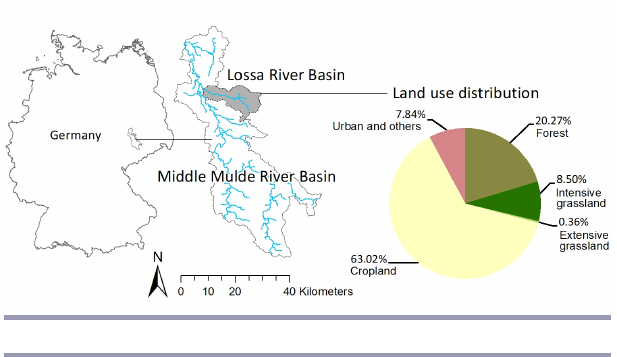
Fig. 3. Map showing the location of the case study area and pie chart showing the proportions of land-use categories. The Lossa River basin is part of the Middle Mulde River basin in central Germany.